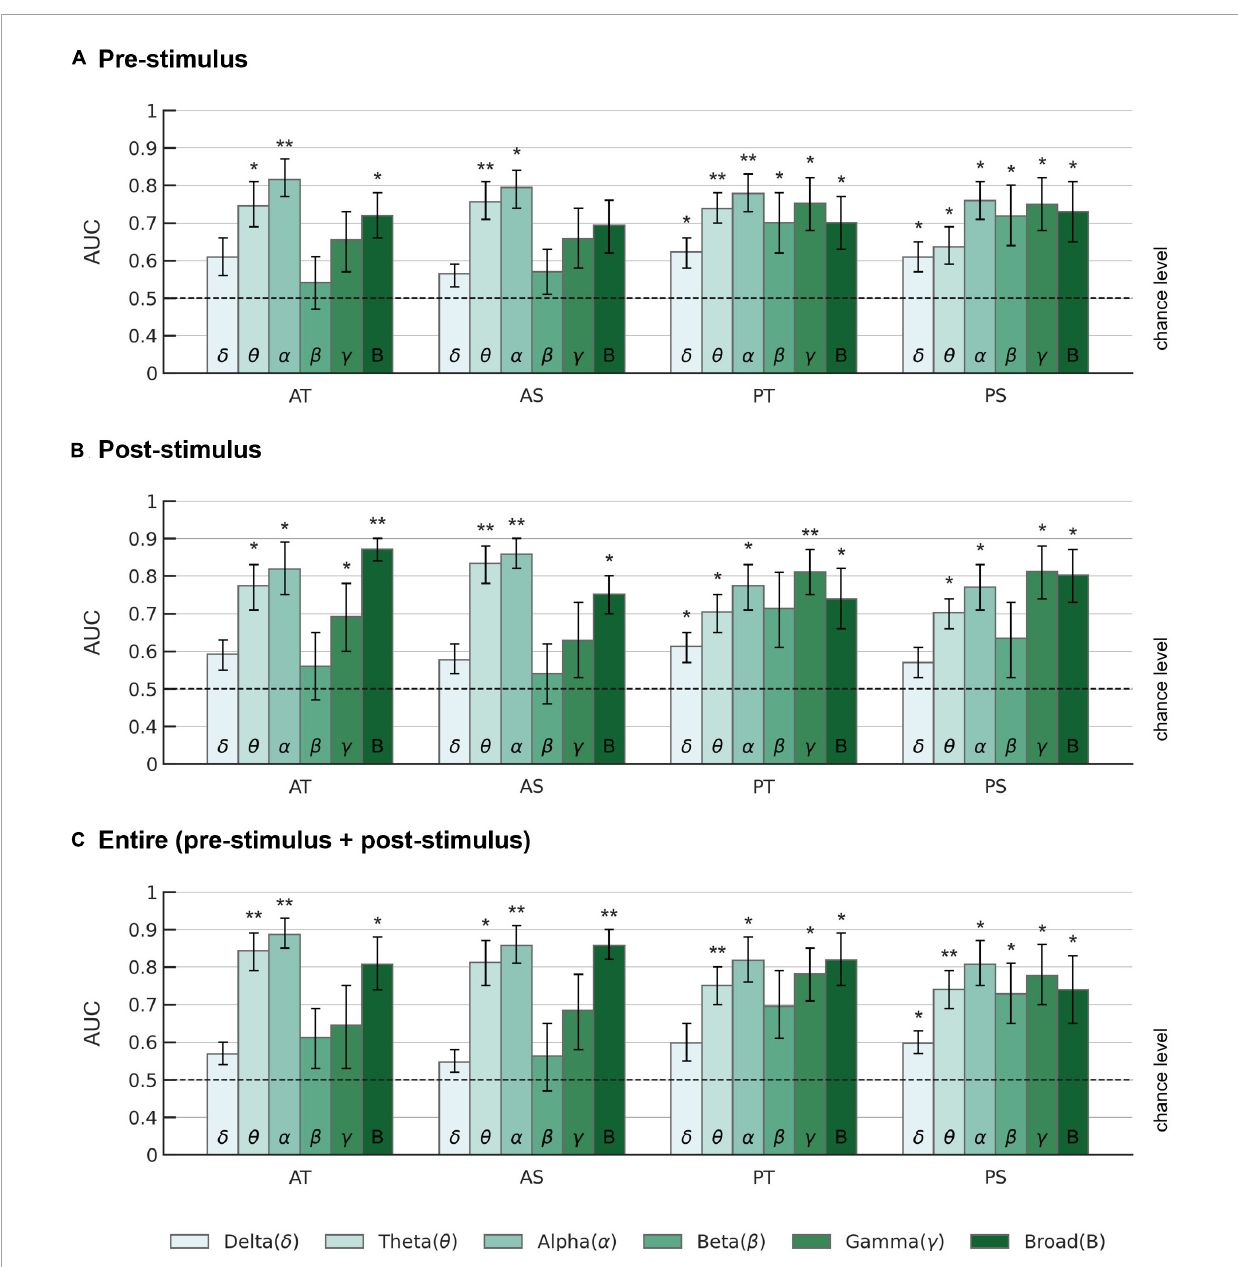
FIGURE5 AUC scores of the EEGNet model across different frequency bands. AUCs are displayed for (A) pre-stimulus, (B) post-stimulus, and (C) entire trial period in each frequency band. AT: active oddball task, target stimuli; AS: active oddball task, standard stimuli; PT: passive oddball task, target stimuli; PS: passive oddball task, standard stimuli. Error bars represent standard errors of the mean. The dotted lines indicate the chance level. Asterisks indicate statistical significance (* p < 0.05; ** p <